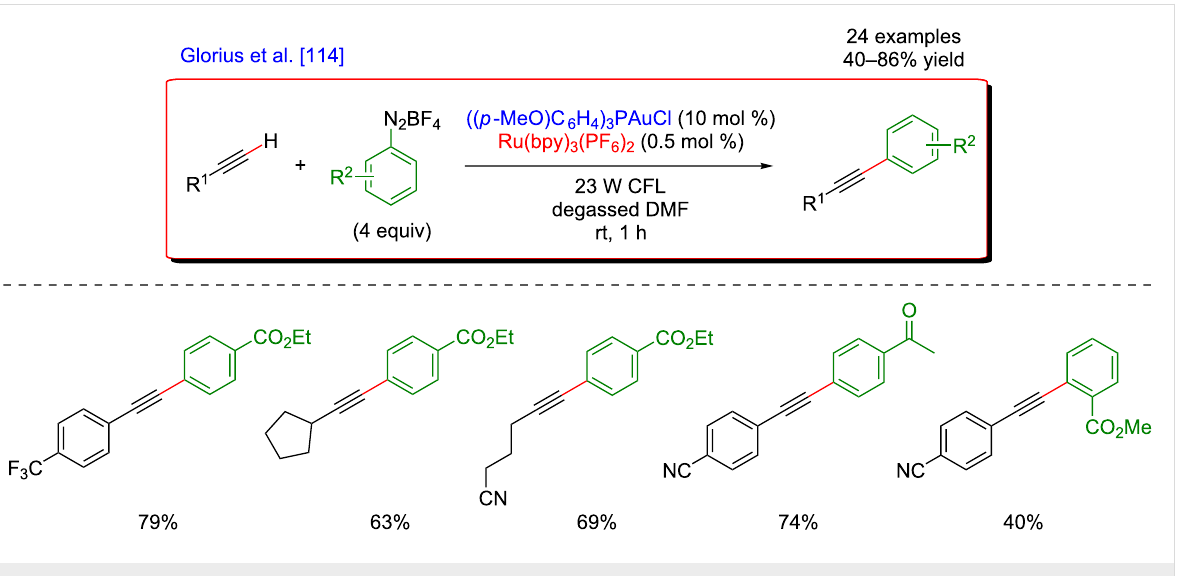
Figure 52: Arylation of terminal alkynes with diazonium salts via dual gold/photoredox catalysis.